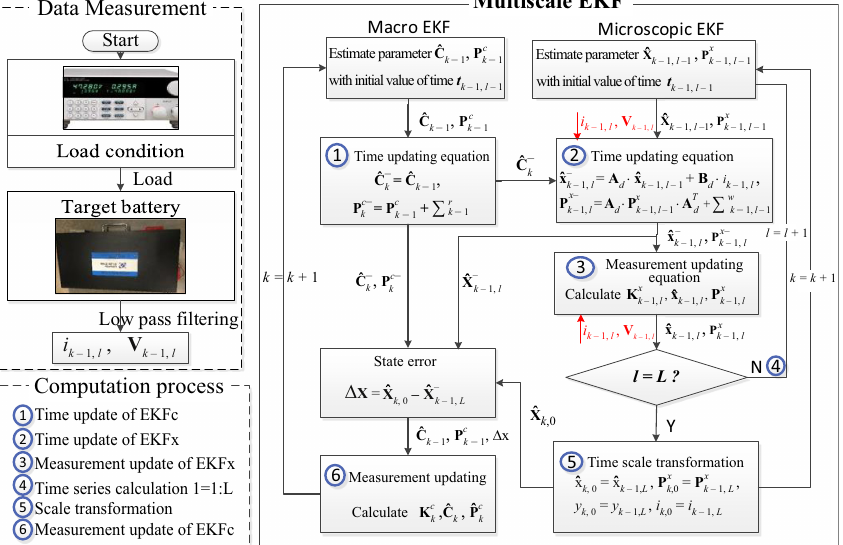
Figure 4. Block diagram